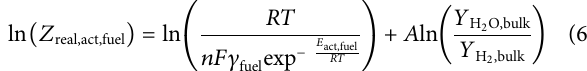
Frontiers in Energy Research |